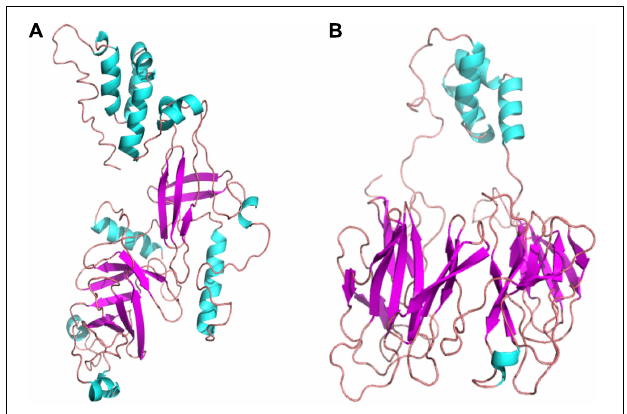
FIGURE 12 | The tertiary structures of 3p.AtFBP113 protein generated by two different modeling servers. (A) The schematic representation of the complete tertiary structure generated by I-TASSER as a ribbon diagram. (B) The ribbon diagram of the 3D structure, generated by Robetta software. In both tertiary structures, the β -pleated sheaths are shown by magenta color and cyan color describes the α -helices, whereas coils (light red) constitute the rest of the protein part. The α -helices form the F-box domain in the N-terminal region, whereas two antiparallel β -pleated sheaths, which form immunoglobulin-like fold, constitute the C-terminal FBA